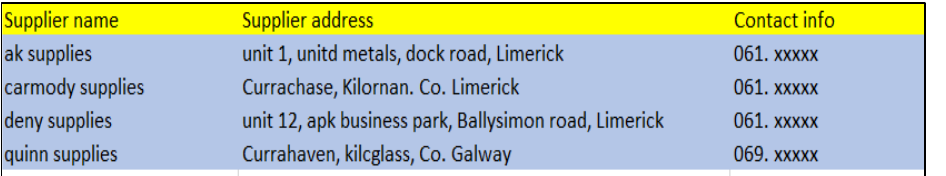
Fig 8c. Pivot automatically created from the data to be sent to the regulatory